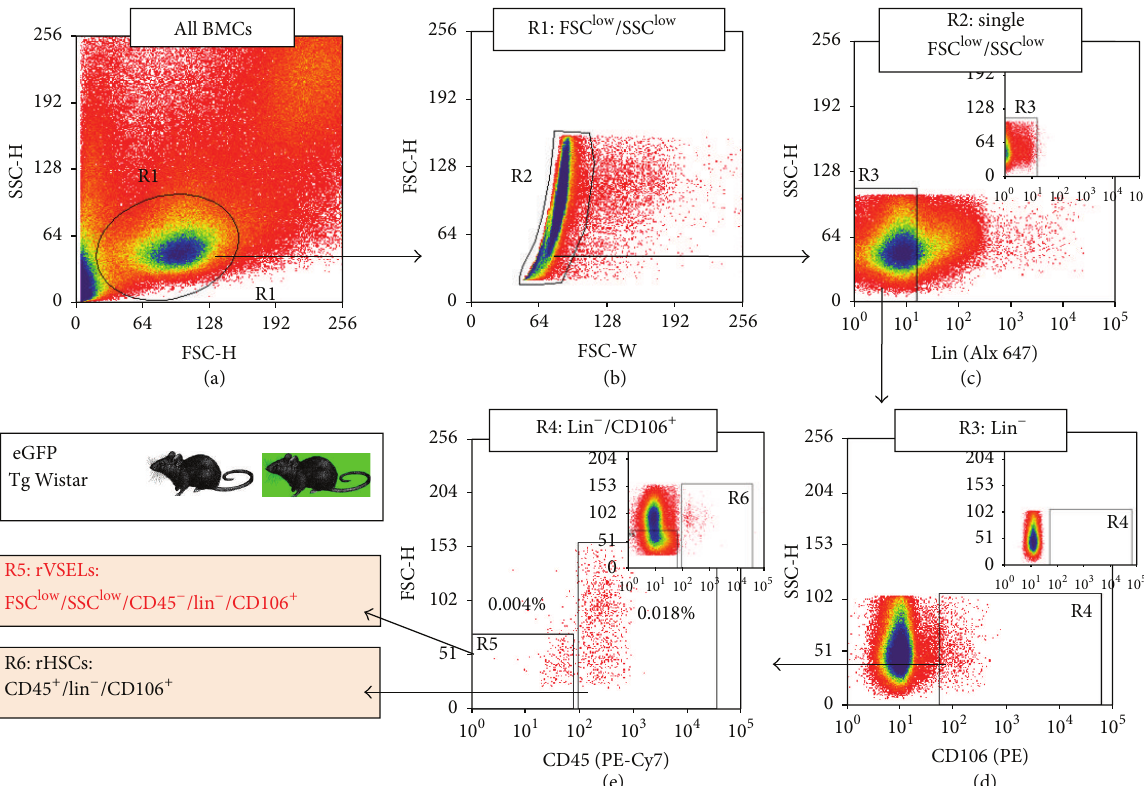
Figure 6: Optimized protocol for isolation of rVSELs from WT and eGFP-expressing rat BM tissue. Rat BM-derived VSELs were isolated from full population of BM cells stained for CD45 (PE-Cy7), Lin markers (TCR 𝛼𝛽 , CD3, CD11b, and CD45RA; Alexa Fluor 647), and CD106 (PE) by MoFlo XDP cell sorter (Beckman Coulter). (a) Total nucleated cells (TNCs) are visualized on dot-plot showing FSC-H versus SSC-H. (b) Small agranular cells from gate R1 (with extension of lymphgate into low values of FSC; Figure 5(a)) are plotted on FSC-W versus FSC-H dot-plot to exclude doublets. (c) Single cells from gate R2 are subsequently analyzed for Lin markers expression. (d) Lin − events included in region R3 are further plotted on dot-plot showing CD106 expression versus side scattered characteristics (SSC-H) of these cells. (e) CD106 + cells from gate R4 are eventually visualized on dot-plot based on their CD45 expression and FSC signal (FSC-H). Rat HSCs are identified as CD45 + /Lin − /CD106 + (region R6), while rVSELs as FSC low /SSC low /CD45 − /Lin − /CD106 + cells (region